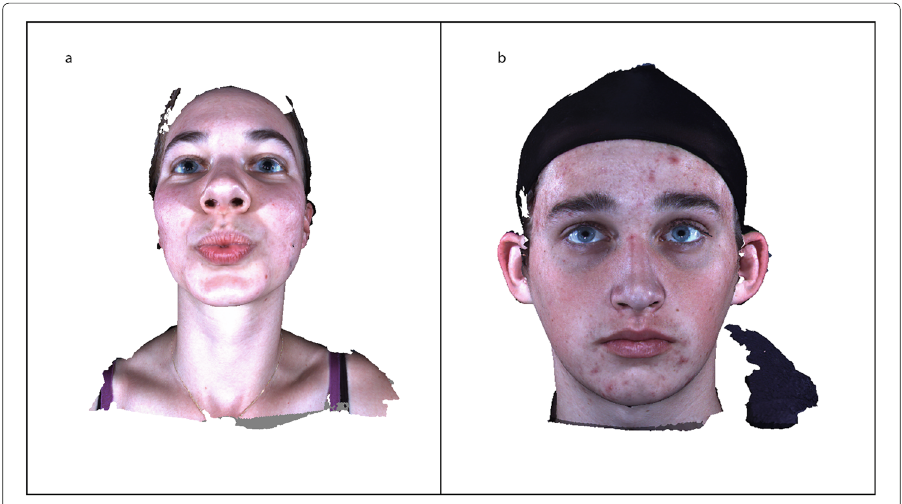
points evenly distributed along the chin. In some projects, eyebrow points are placed at the center, bottom, or top of brow arcs. Good choices for landmarks points include those near high curvature or boundaries on objects. Here, eyebrows are marked anatomically at the supraorbital ridge or eyebrow